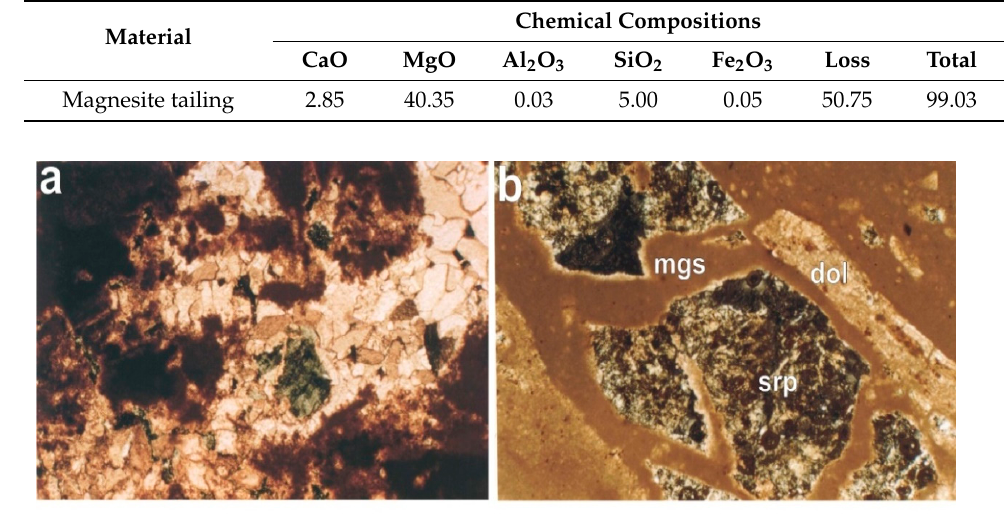
Figure 2. ( a ). Microphotographs where fragments of serpentine (srp), the replacement of magnesite (mgs) by coarse grain dolomite (dol), are observed (XPL, ×68); ( b ) fragments of serpentine in the magnesite vein. In the contact of magnesite with the serpentine fragment, dolomite is formed (XPL, ×68).